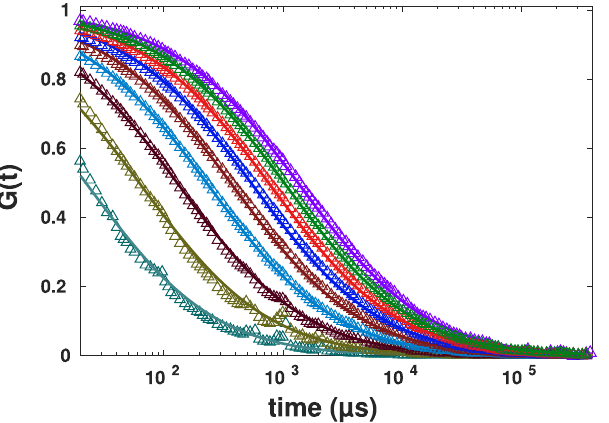
Figure 5. Simulation results for mimicked spot variation FCS for the values of the effective beam waist ranging from r 0 to 0.2 r 0 (from right to left) for anomalous diffusion (symbols), together with theoretical FCS curves for the same beam waists according to Eq. 5.